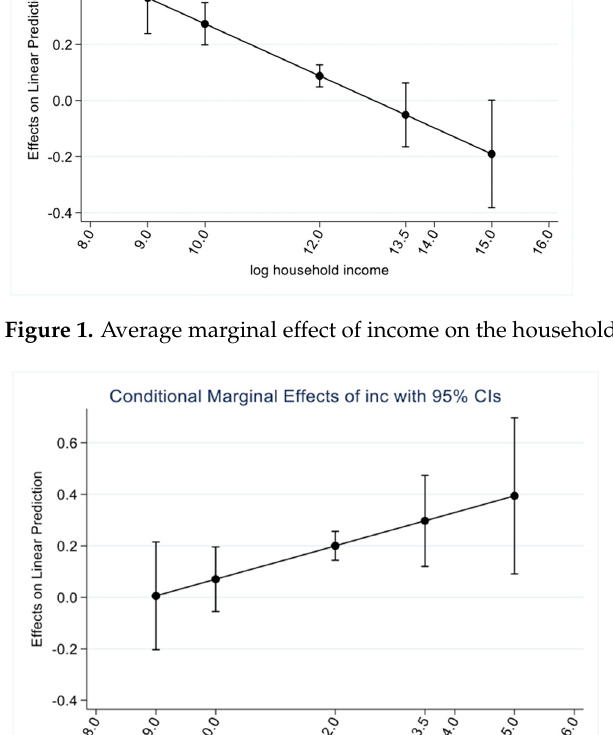
Figure 1. Average marginal effect of income on the household consumption of sugary drinks.